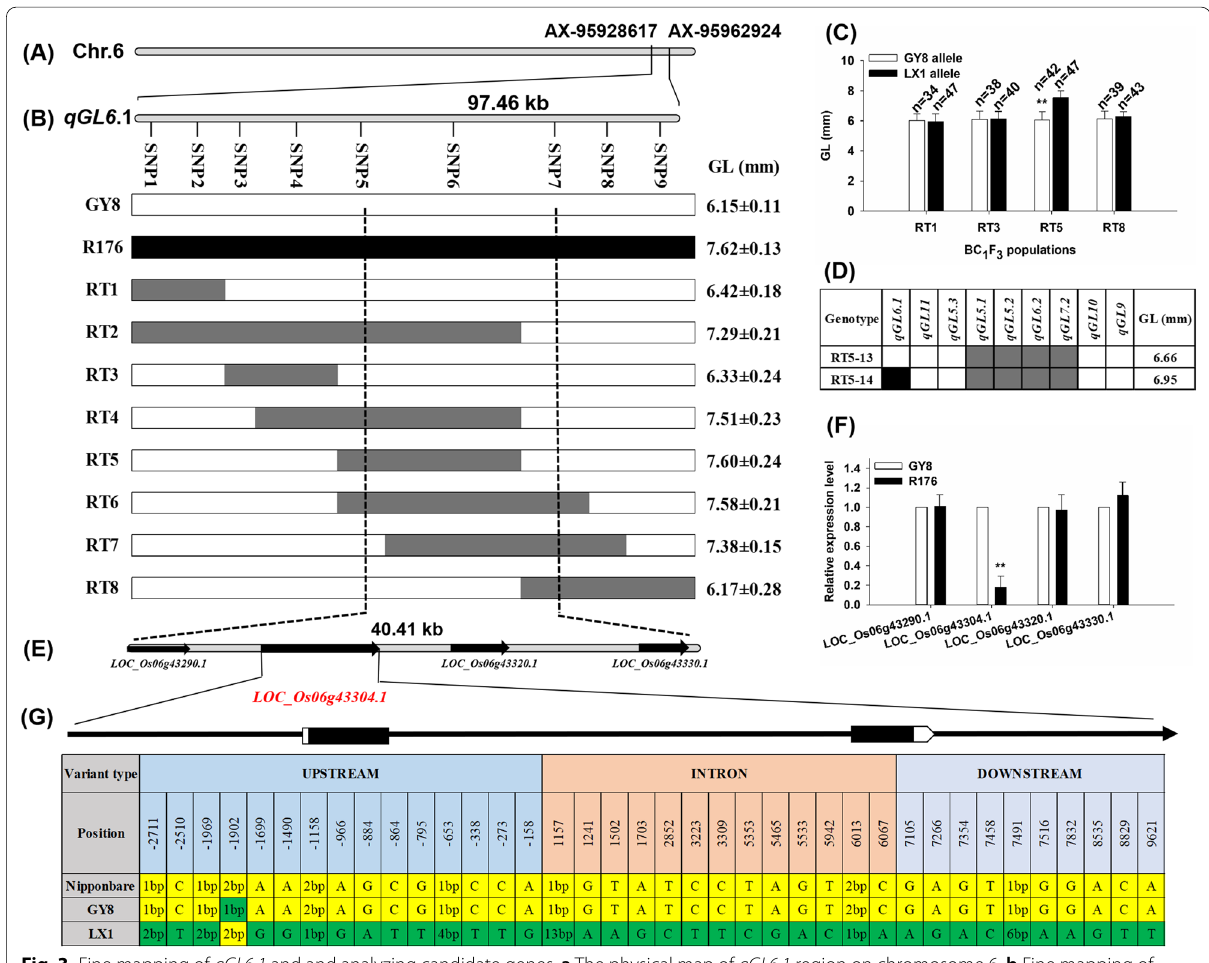
Fig. 3 Fine mapping of qGL6.1 and and analyzing candidate genes. a The physical map of qGL6.1 region on chromosome 6. b Fine mapping of qGL6.1 with eight recombinants. The black bar with markers denotes the recombinant sites. The white, black and gray boxes stand for genotypes of Gangyuan8, R176 and heterozygote, respectively. Vertical dotted lines denote the target region. c The progeny test in the BC 1 F 3 populations derived from the heterozygous recombinants R1, R3, R5 and R8. d Two BC 1 F 3 plants derived from heterozygous recombinants R5 carried different alleles at qGL6.1 locus without the interference of other QTLs. e Four candidate genes in the fine mapping region. Arrows indicate direction of gene orientation. f The expression level of four candidate genes by qPCR analysis. g Variations in the upstream, intron and downstream region of LOC_Os06g43304.1 among Nipponbare, Gangyuan8 (GY8) and Liaoxing1